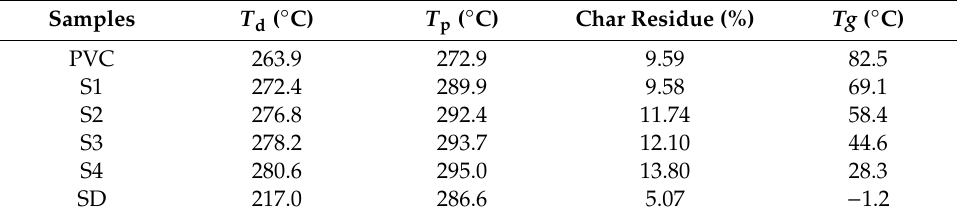
Figure 3. ( a ) TGA curves of PVC materials; ( b ) DTG curves of PVC materials; ( c ) DMA curves of PVC materials; ( d ) FT-IR of PVC materials. Table 2. TGA and DSC data for PVC materials.